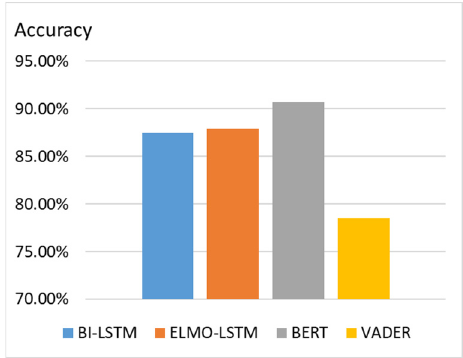
Figure 15. Accuracy of sentiment classification using different models.